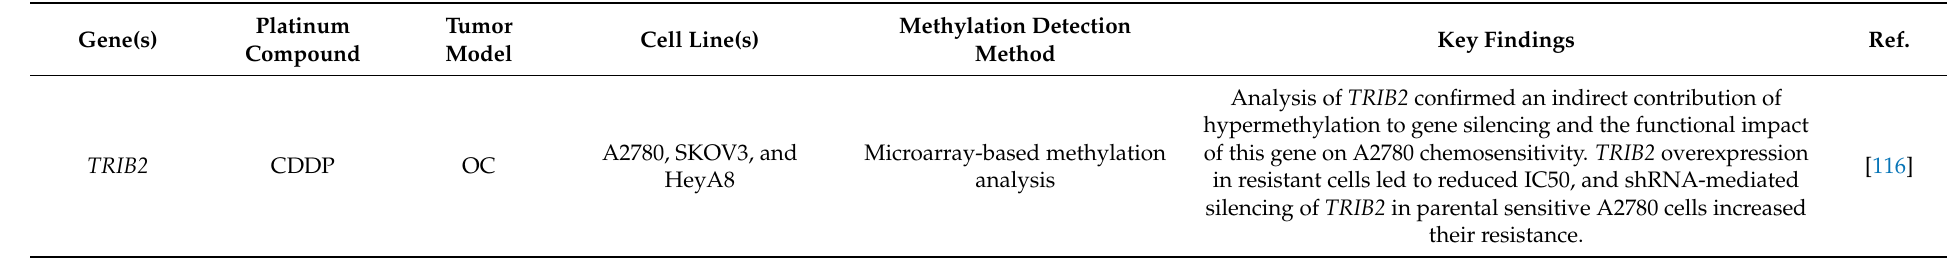
Table 2. Promising DNA methylation markers predictive of resistance to platinum-based chemotherapy (studies with patient samples). Genes related with the three most common platinum drug resistance pathways are indicated as [T], genes encoding proteins’ transporters, related with cellular uptake of platinum drugs;